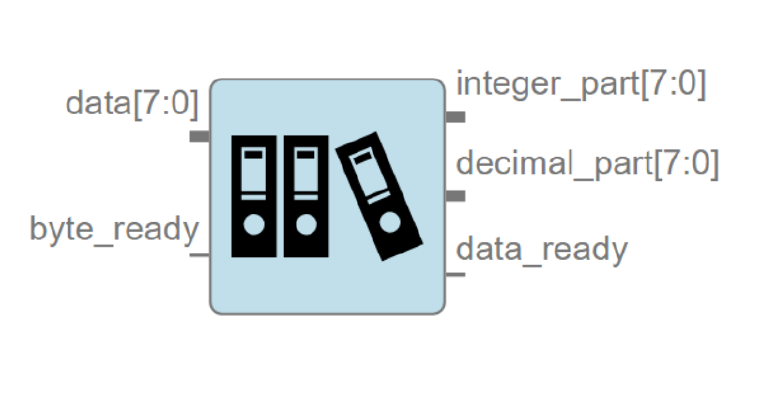
Figure 8. Module to arrange data from